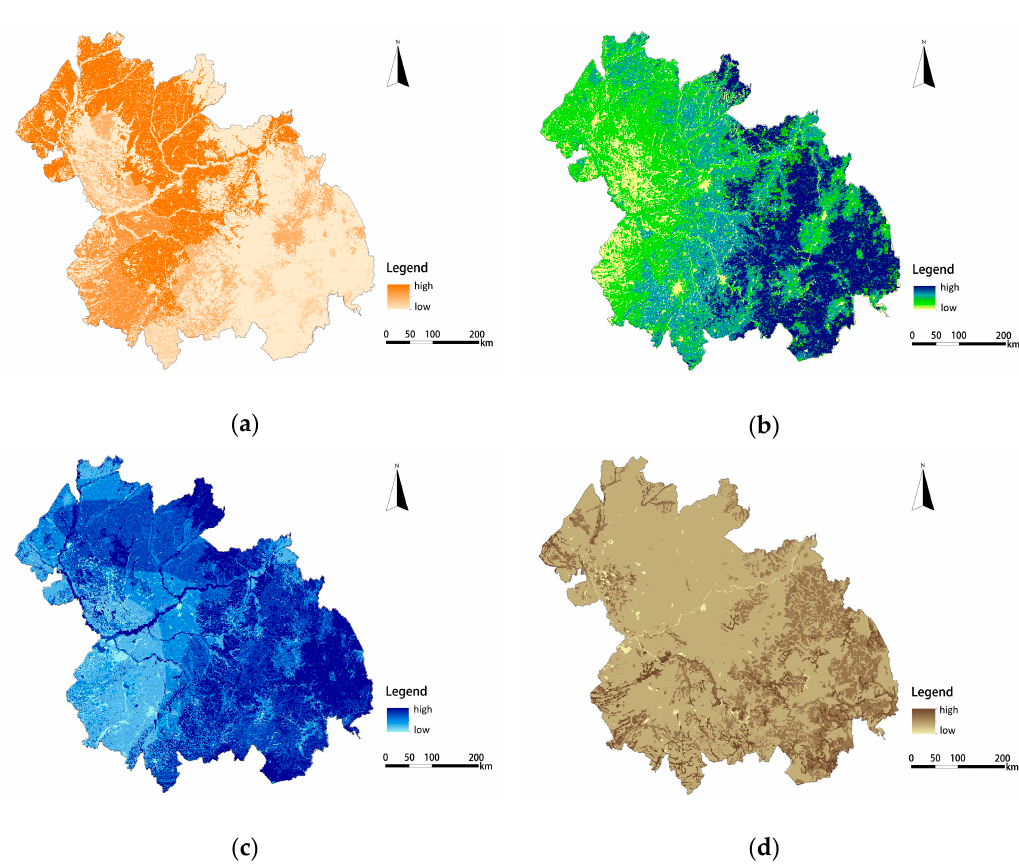
Figure 3. The evaluation value of ecosystem functions: ( a ) The evaluation value of food supply services; ( b ) The evaluation value of biodiversity conversation services; ( c ) The evaluation value of water conversation services; ( d ) The evaluation value of soil conversation services.